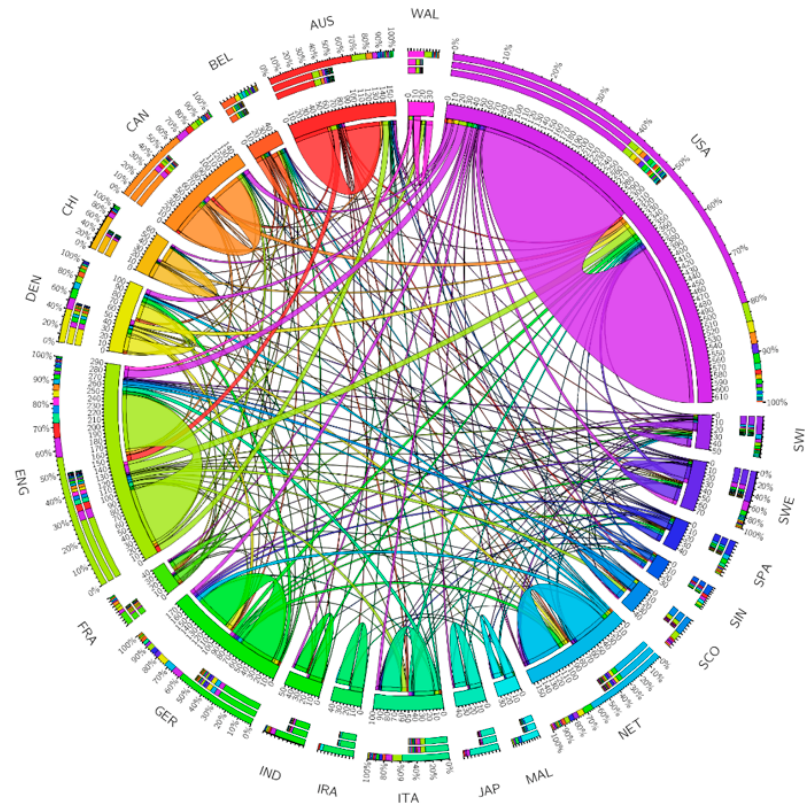
Figure 2. Collaboration network between the top 20 countries by the number of publications. The outer rim reflects the volume of collaborations between each country and the other countries in the top 20, showing collaboration among countries. Abbreviation: USA, the United States of America; ENG, England; GER, Germany; AUS, Australia; NET, the Netherlands; CAN, Canada; DEN, Denmark; ITA, Italy; SWE, Sweden; CHI, China; IND, India; SWI, Switzerland, BEL, Belgium; SPA, Spain; MAL, Malaysia; FRA, France; JAP, Japan; SCO, Scotland; IRA, Iran; SIN, Singapore.